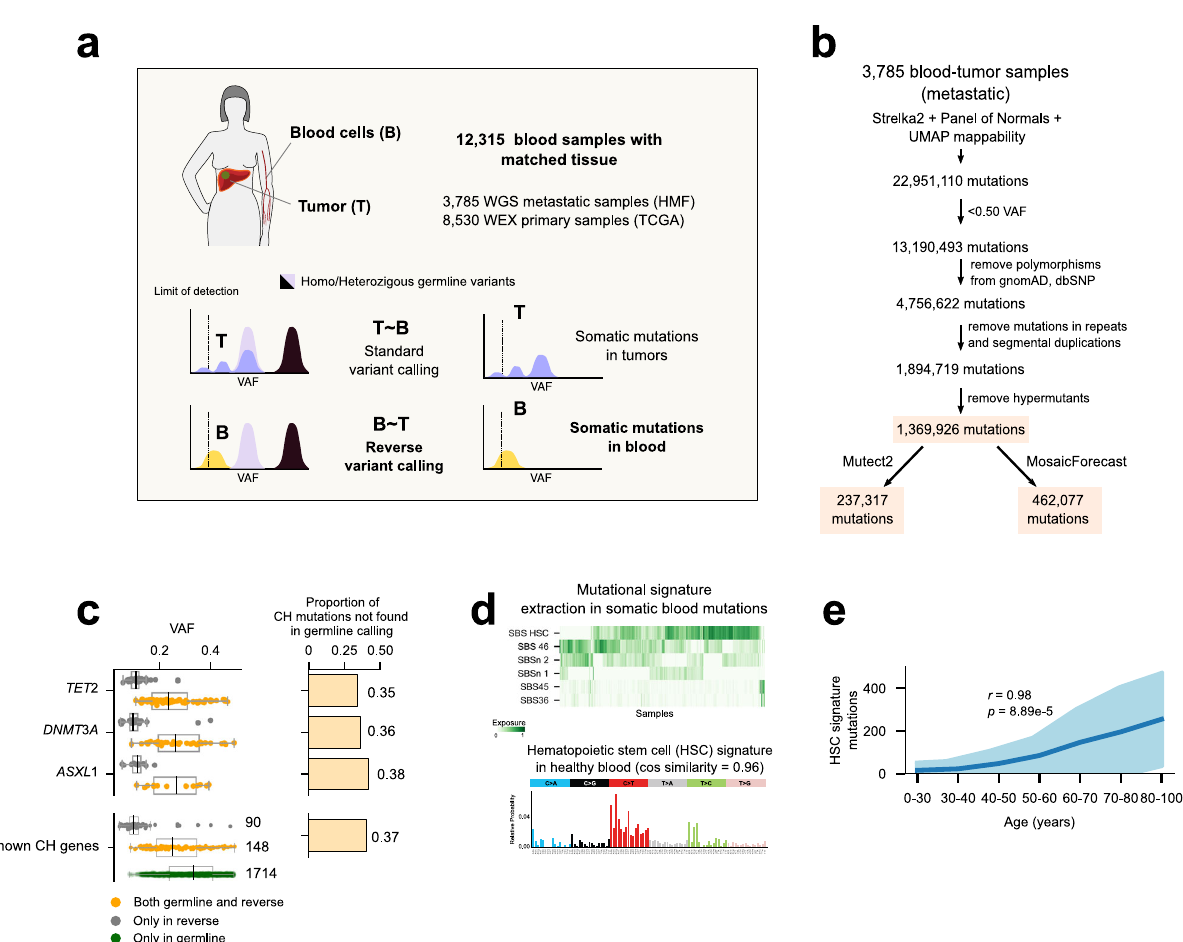
Fig. 1 The reverse calling approach to detecting blood somatic mutations. a Somatic mutations in blood are identi fi ed by comparing variants in the blood/ tumor paired samples from a cancer patient. We applied this approach to two cohorts of primary and metastasis tumors totalling 12,315 blood donors with no known hematologic malignancy. b Flowchart of the reverse calling and fi ltering approach. Numbers correspond to mutations remaining in the dataset of the metastasis cohort (full, mosaic or mutect) after each fi ltering step. c Somatic mutations identi fi ed by the reverse calling and a one-sample germline variant calling across blood samples in the metastasis cohort ( N = 3,785). Boxplots represent the distribution of VAF of variants affecting well-known CH driver genes identi fi ed only by the reverse calling (gray), by both approaches (yellow) or only by the germline calling (green). In the boxplots, the box represents the second and third quartiles, separated by a line indicating the median; the whiskers represent the minimum and maximum of the distribution excluding outliers. Right-hand barplots illustrate the fraction of mutations affecting each gene that are identi fi ed only by the reverse calling approach. d Top, activity of mutational signatures in the blood samples of donors across the metastasis cohort ( N = 3,785) identi fi ed using the mosaic set; bottom, mutational pro fi le of tri-nucleotide probabilities of one of the signatures extracted from the cohort which highly resembles (cosine similarity = 0.96) that of a signature active in healthy hematopoietic stem cells (HSCs). e Relationship between the number of mutations contributed by the HSC signature across blood samples in the metastasis cohort and the (binned) age of their donors. The mean activity of the signature across donors of each bin is represented as the dark blue line, with its standard deviation in light blue color. A signi fi cant positive correlation between the two variables is apparent. The p-value corresponds to the Pearson ’ s regression coef fi cient. WGS whole genome sequencing, HMF metastasis cohort, TCGA primary cohort, WEX whole exome sequencing, VAF variant allele frequency, CH clonal hematopoiesis, SBS single base substitution, HSC hematopoietic stem cell, cos cosine. Source data for panels c , d and e are provided as Source Data fi